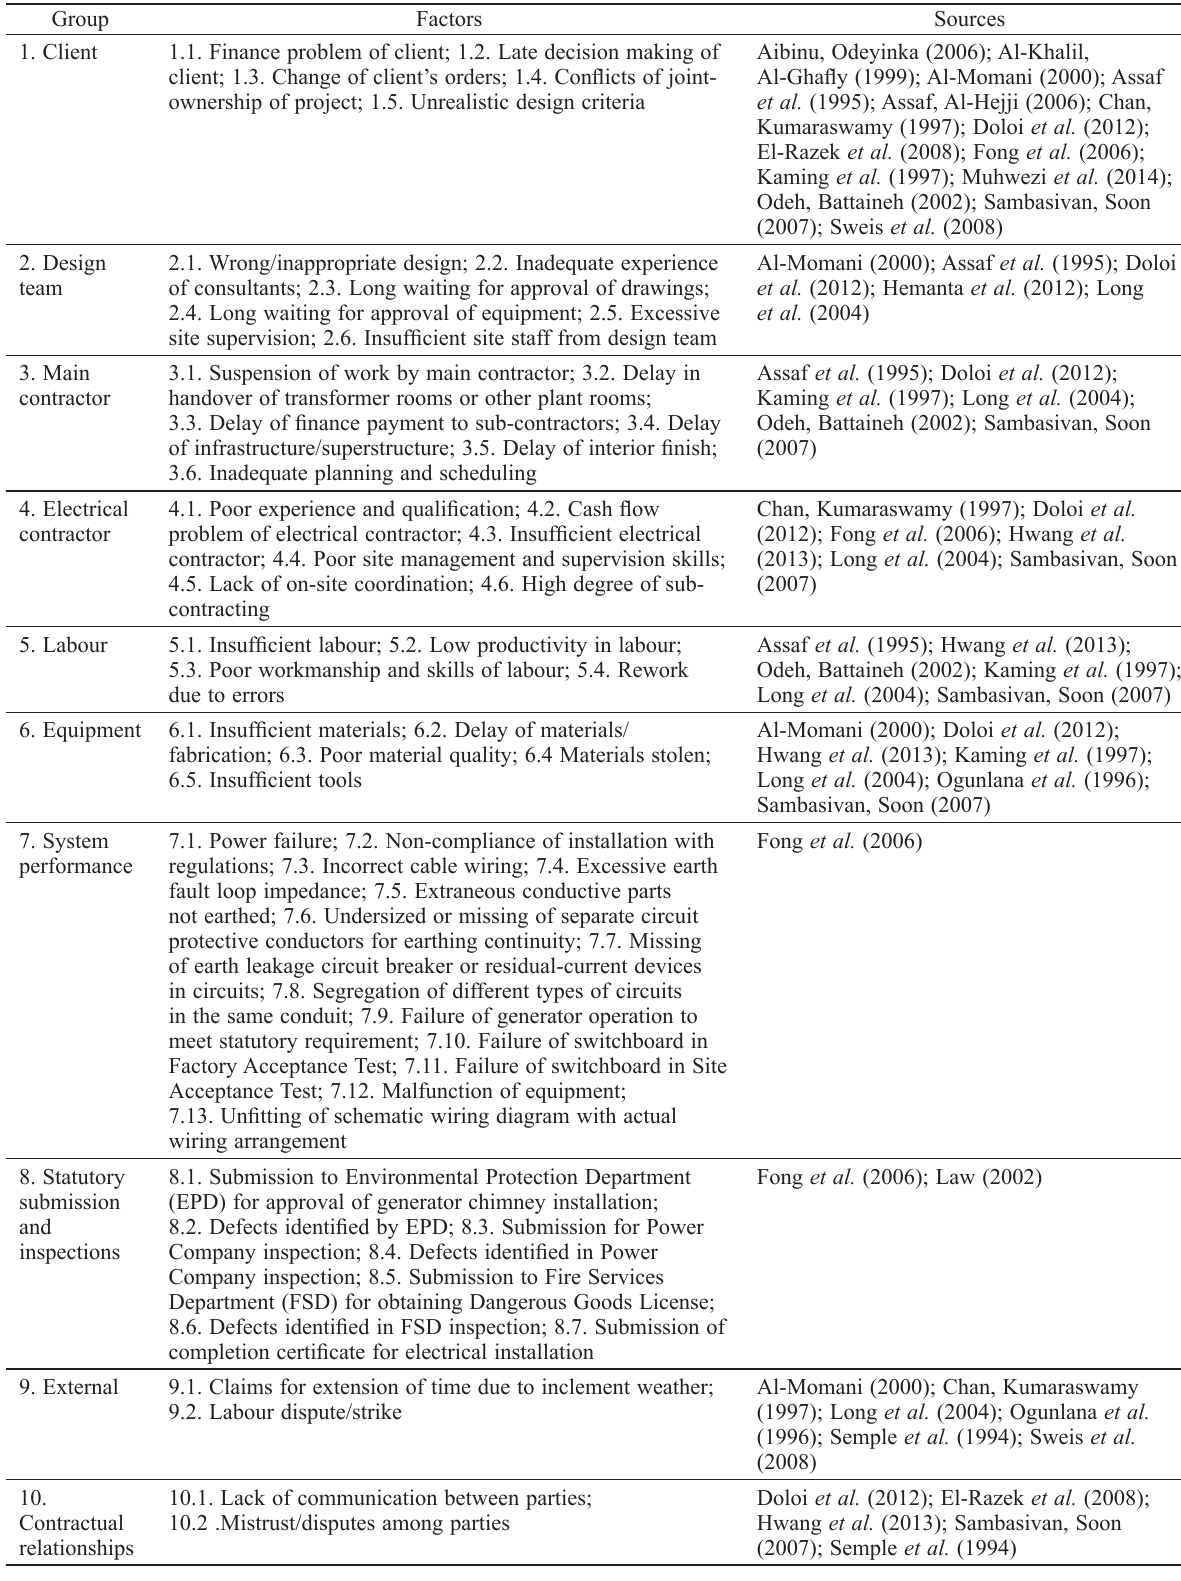
Table 1. Grouping and sources of delay factors Group Factors